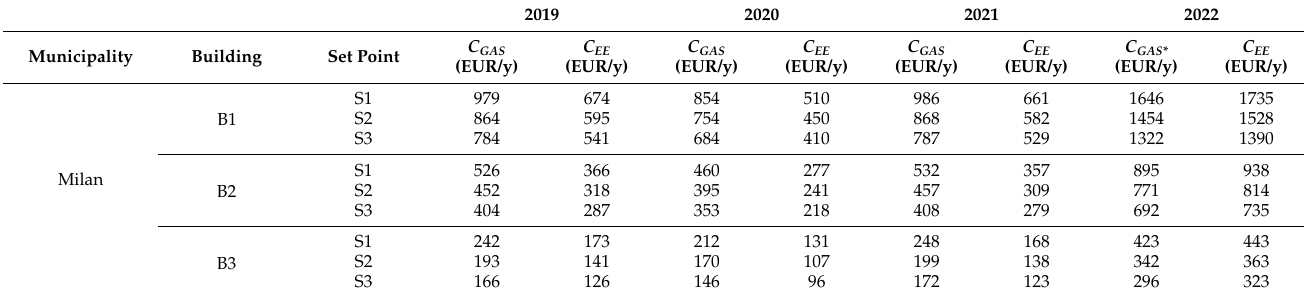
Table 7. Economic analysis results, years 2019–2022: yearly costs for the two different heat generation